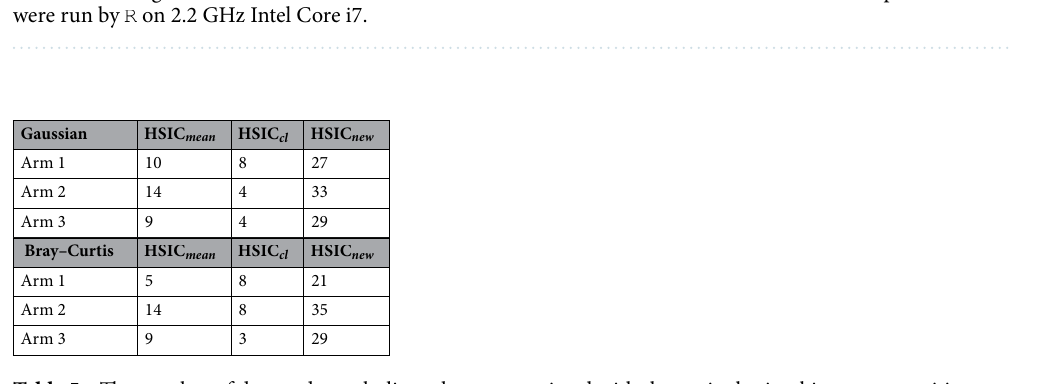
Table 5. The number of detected metabolic pathways associated with the vaginal microbiome